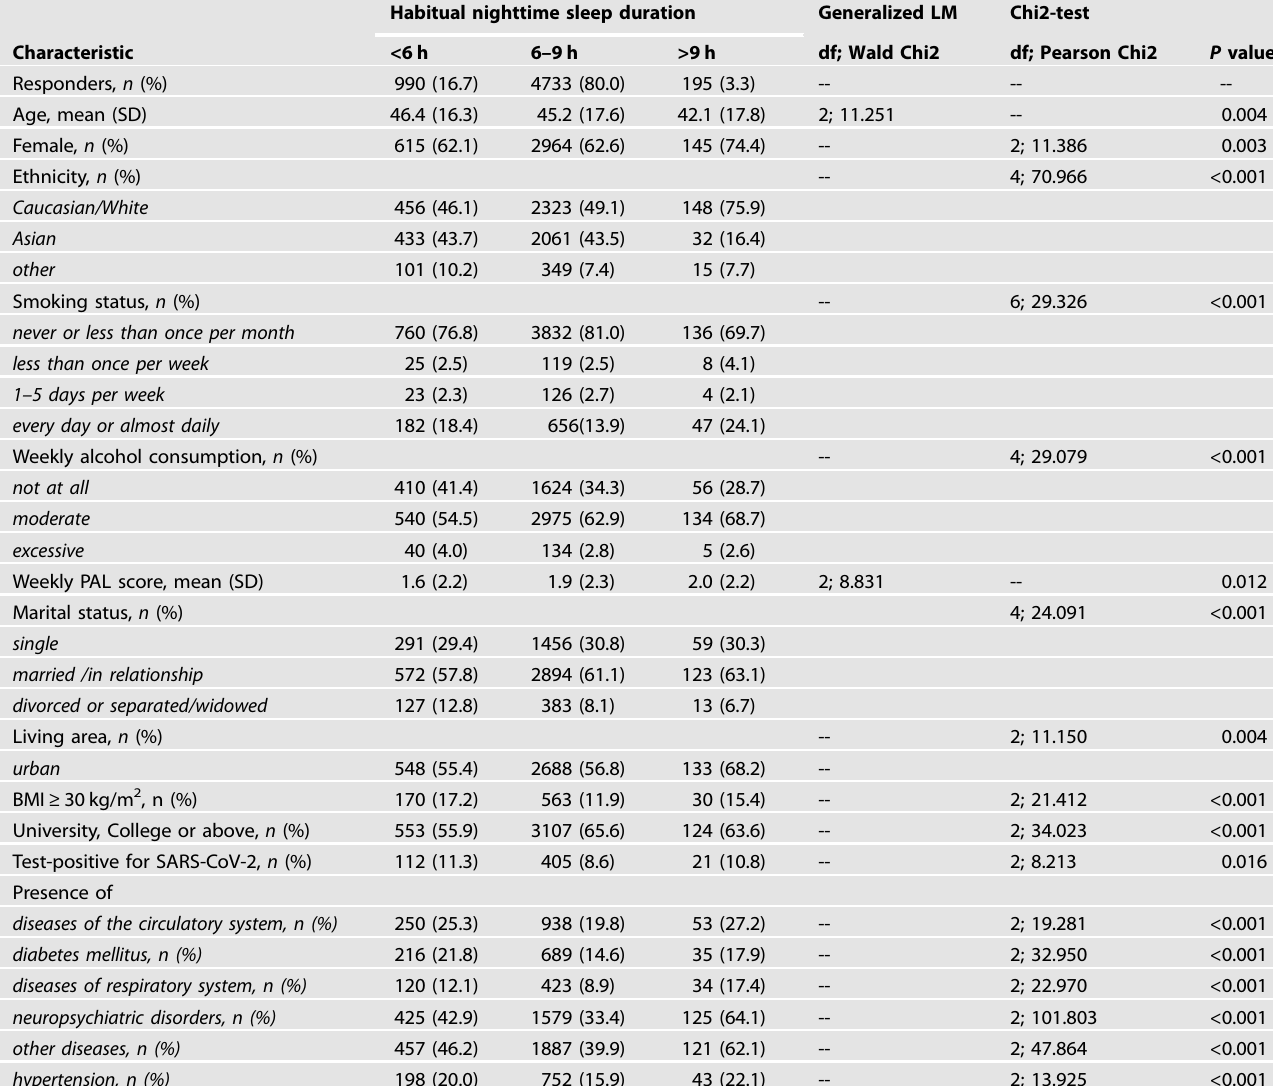
Table 1. ICOSS-2 characteristics of respondents who received two doses of mRNA vaccines split by habitual nighttime sleep